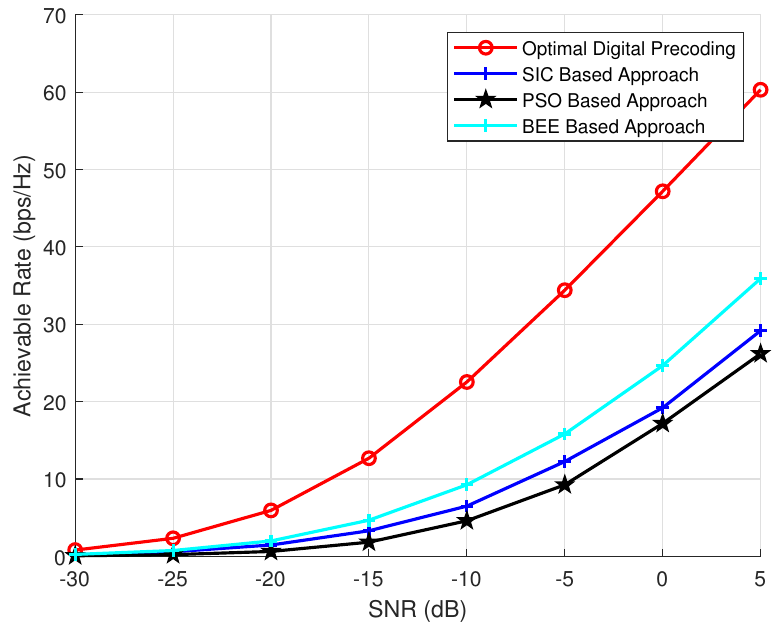
Figure 4. Simulations using N T = 144, N R = 36, N rf = 8.